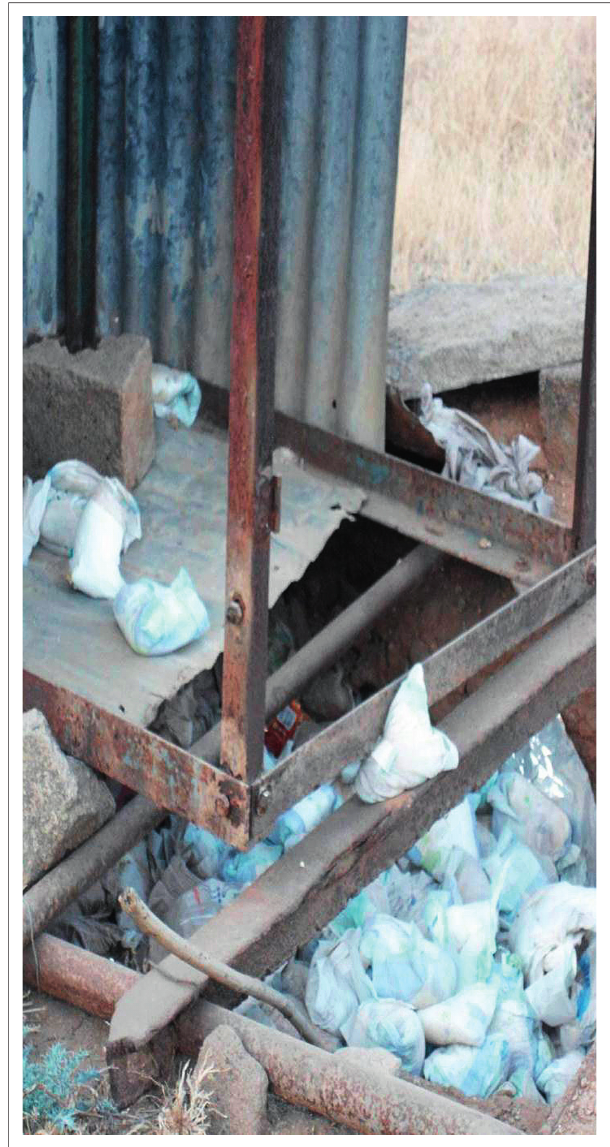
FIGURE 2: An open toilet filled with soiled